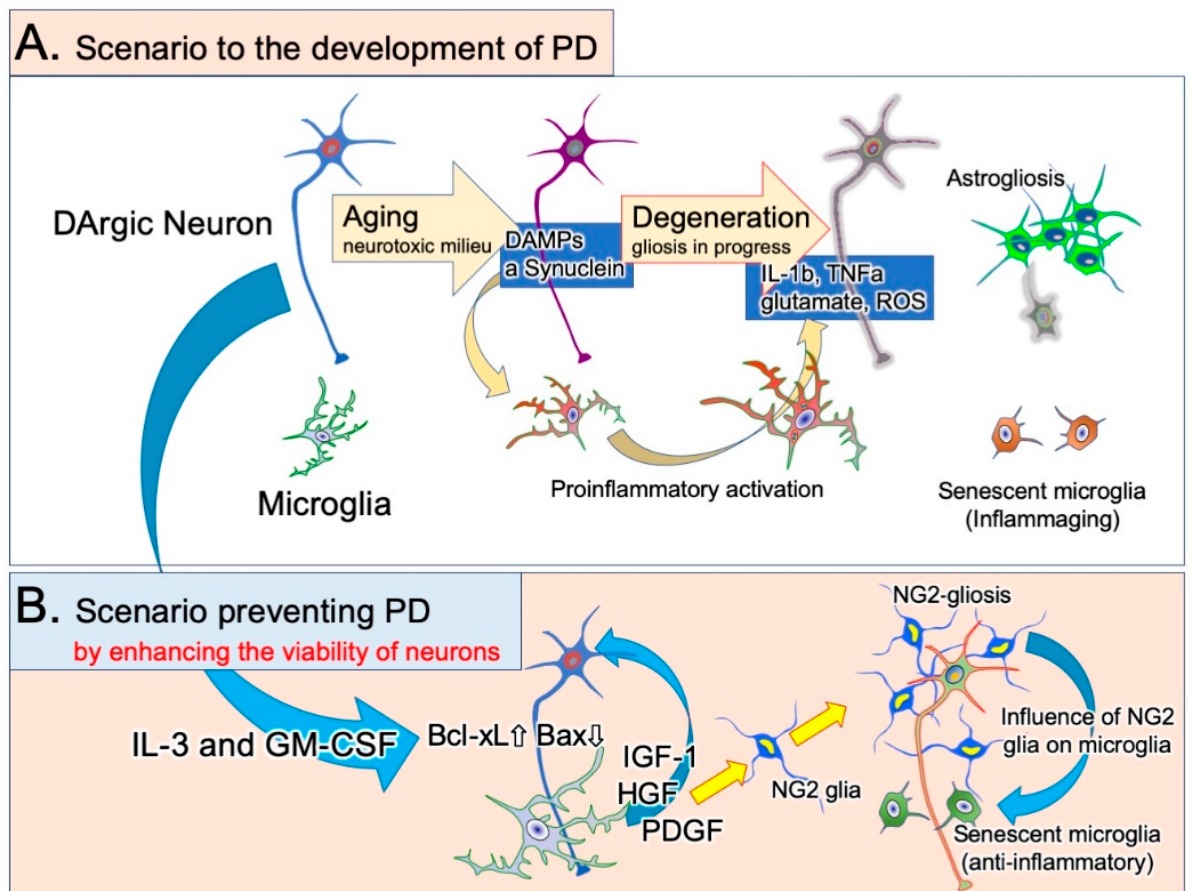
Figure 3. Neuronal viability and microglial phenotype changes in the SNc of a rat PD model. ( A ) With age, a toxic milieu forms around the DAergic neurons and adds to the intrinsic toxic mechanisms. Degenerating neurons generate damage-associated molecular patterns (DAMPs) and accumulate Lewy bodies containing α -Syn fibrils within their somata, inducing proinflammatory microglia. Activated microglia further stimulate neuronal degeneration by releasing neurotoxic mediators. Finally, most DAergic neurons are lost and astrogliosis occurs. Senescent microglia may lose their neurotrophic properties but can still generate neurotoxic mediators. ( B ) The cytokine mixture (GM-CSF + IL-3) can inhibit progressive neurodegeneration by increasing the expression of the antiapoptotic factor Bcl-xL and suppressing the expression of the proapoptotic factor Bax. Then, microglial neurotoxic activation is avoided and activated microglia release more neurotrophic factors. Microglia-derived growth factors play neuroprotective roles and enhance the survival of DAergic neurons. Microglia-derived PDGF and HGF stimulate the proliferation of neural/glial antigen 2 (NG2) glia, resulting in NG2 gliosis. NG2 glia may be involved in maintaining the homeostatic functions of microglia. More detailed information is described elsewhere